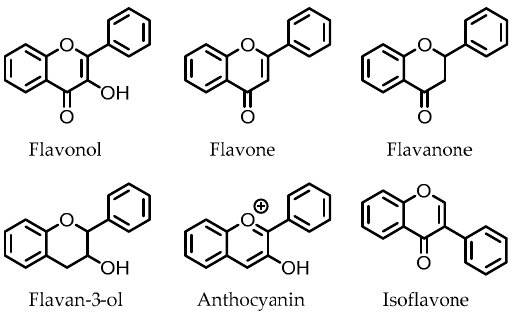
Figure 4. Core structures of flavonoid subclasses. The phenyl rings may be functionalized at dif- ferent positions (i.e., -OH, -OMe).